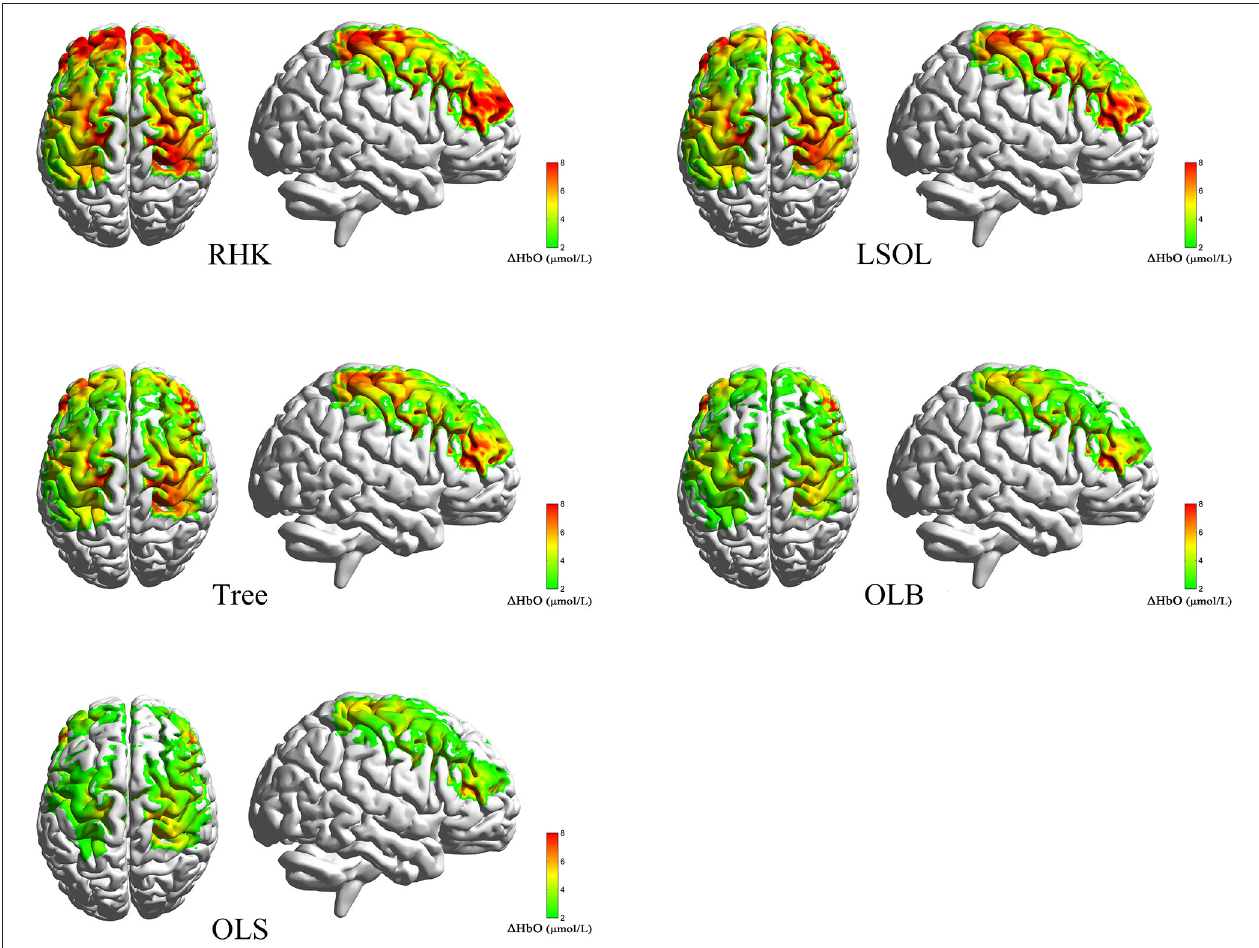
FIGURE 4 | Averaged concentration changes of oxyhemoglobin ( 1 HbO) during postures. RHK, right heel kick; LSOL, left lower body and stand on one leg; OLB, one-leg balance; OLS, normal one-leg standing.